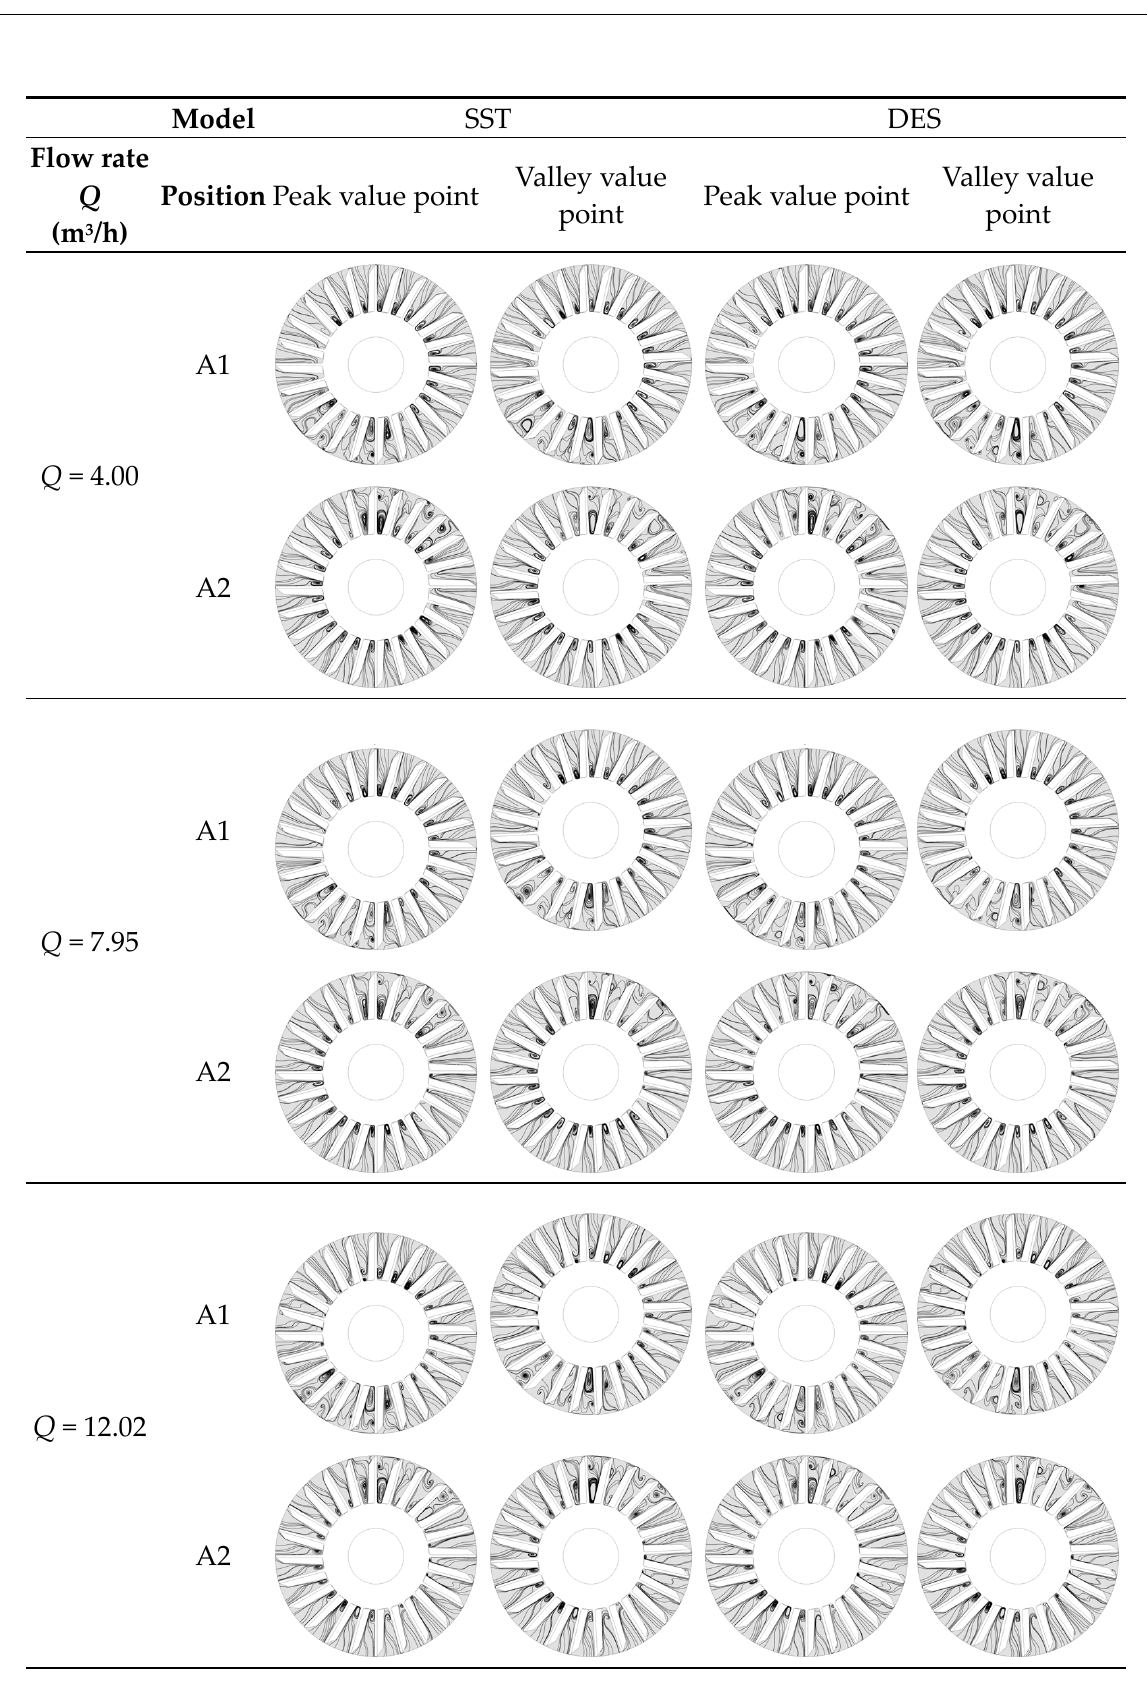
Figure 10. Velocity streamlines distributions of the SST and DES models at A1 and A2 near the outlet at the peak and valley points of the head.